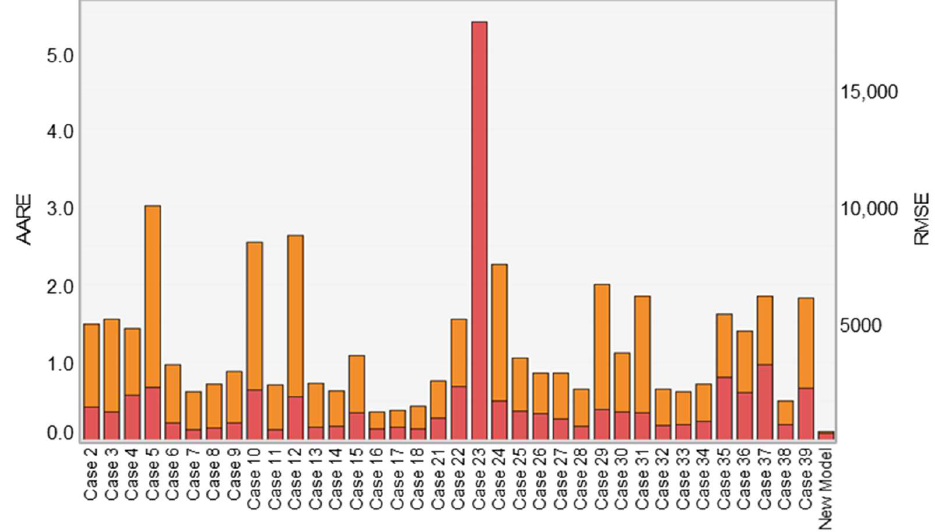
Figure 11. Model evaluation for pressure gradient predictions in terms of average absolute relative error and RMSE.